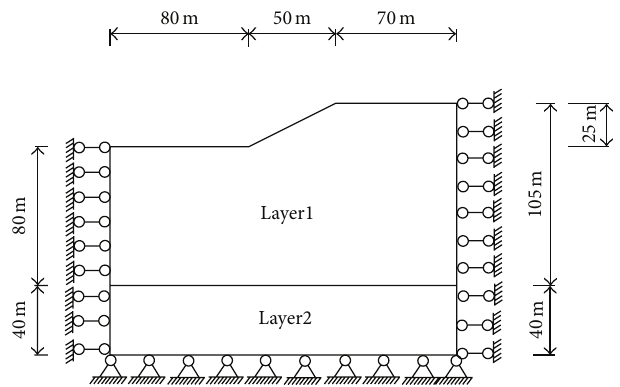
Figure 14: Studied region for the engineering problem in Section 2 treated with Ansys.